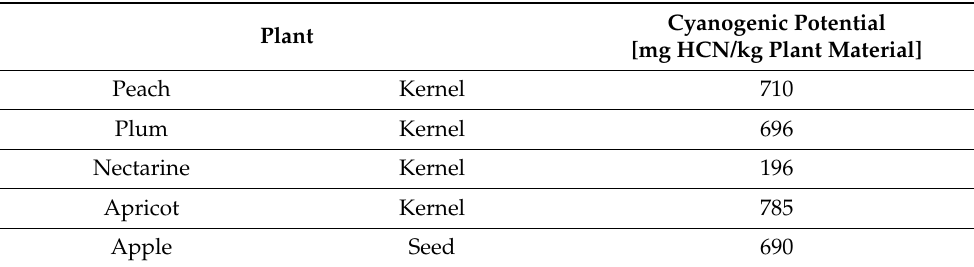
Table 2. Concentration of hydrogen cyanide released in the process of enzymatic hydrolysis of amygdalin in various parts of plant tissues [21].